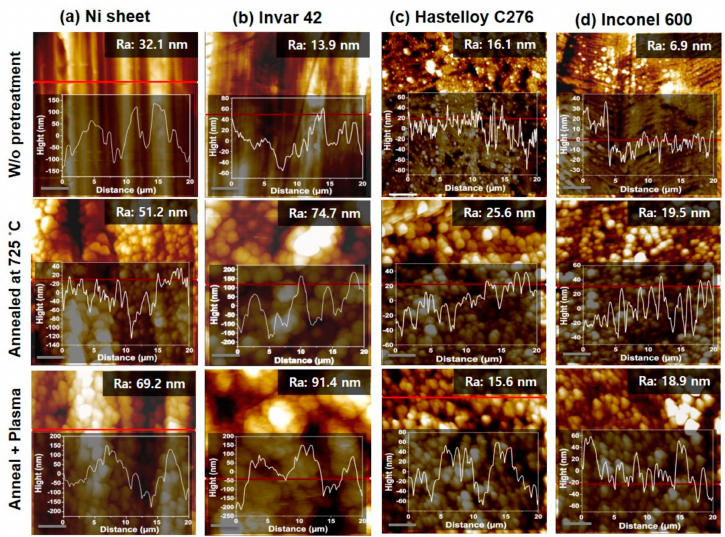
Figure 9. AFM results of ( a ) Ni sheet, ( b ) Invar 42, ( c ) Hastelloy C276 and ( d ) Inconel 600 with respect to di ff erent pretreatments. Each topographic image has height profile of the